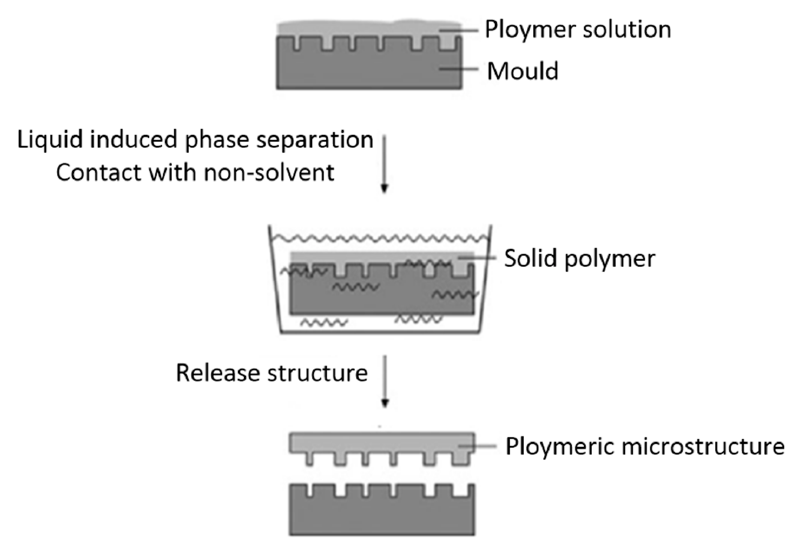
Figure 15. Schematic representation of the PS µ M by the wet method, adapted from [126].